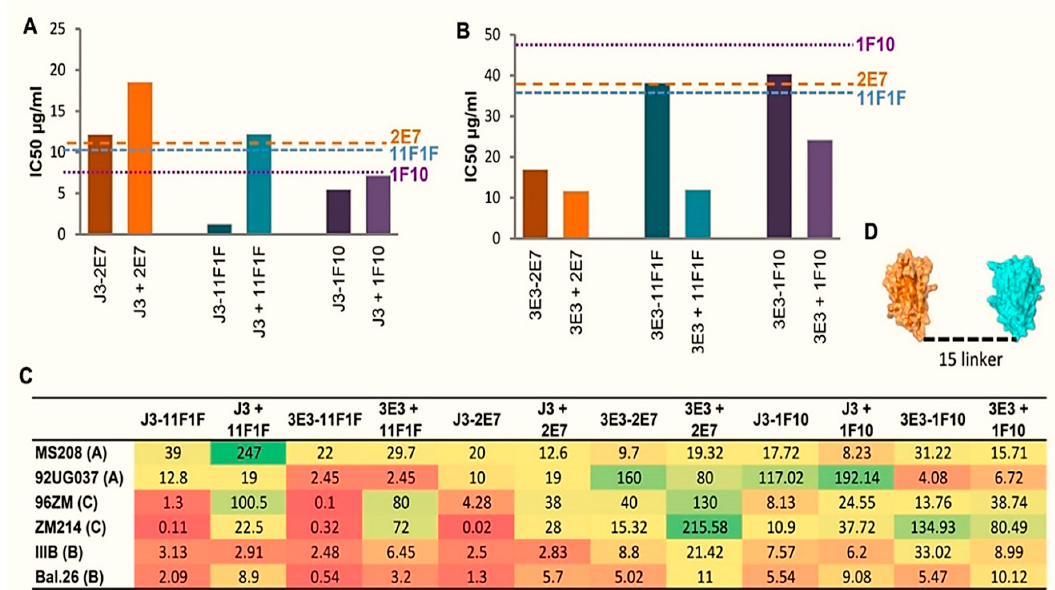
Figure 7. Broad and Potent HIV Neutralization by bi-specific VHH. ( A , B ) IC50 values in µg/ml for the indicated bi-specific VHH in comparison with the unlinked component VHH against viruses (( A ) Du172.17 or ( B ) TV1.2) that were resistant to one of the VHH. Dotted lines represent the IC50 (µg/mL) for each component VHH and are color-coded in line with the legend. ( C ) IC50 nM for the indicated bi-specific VHH and the unlinked component VHH against the viruses indicated. IC50 values were generated from duplicate titrations of VHH onto TZM-bl cells as described in the materials and methods. Schematic representations of J3-2E7 bi-specific VHH ( D ).